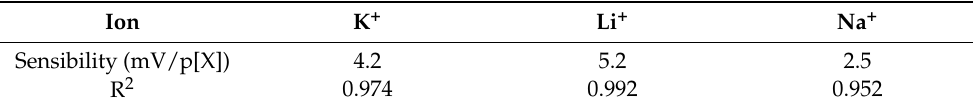
Figure 6. The flat band potential V FB variation versus ( a ) K + , ( b ) Li + and ( c ) Na + concentrations from 10 − 5 M to 10 − 1 M. Inset: the capacitive responses of Si/SiO2/HfO 2 structure with 15 nm HfO 2 thickness for interfering ions (Figure S1 in Supplementary Material). Table 2. Sensitivities and dynamic ranges obtained with the implanted structure for K + , Li + and Na + detection (10 − 5 M to 10 − 1 M).